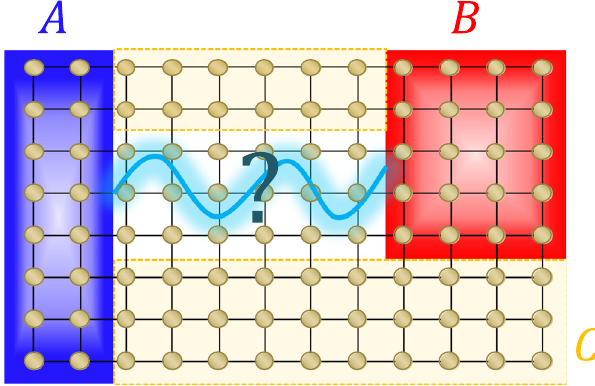
FIG. 1. Entanglement between two separated subsystems A and B . Considering the tripartite entanglement between subsystems A , B , and C , long-range entanglement at nonzero temperatures can be detected. It can also be observed in topologically ordered, quantum, many-body systems. This study aims to elaborate on the observation and prove that (more than) tripartite entanglement is required for long-range entanglement. The quantum entangle- ment between two systems is shown to decay exponentially with distance at arbitrary nonzero temperatures, in any quantum Gibbs state with short-range interacting Hamiltonians. Here, the entanglement-length scale, at most, grows in a polynomial manner with the inverse temperature β , as stated in inequalities (1) –